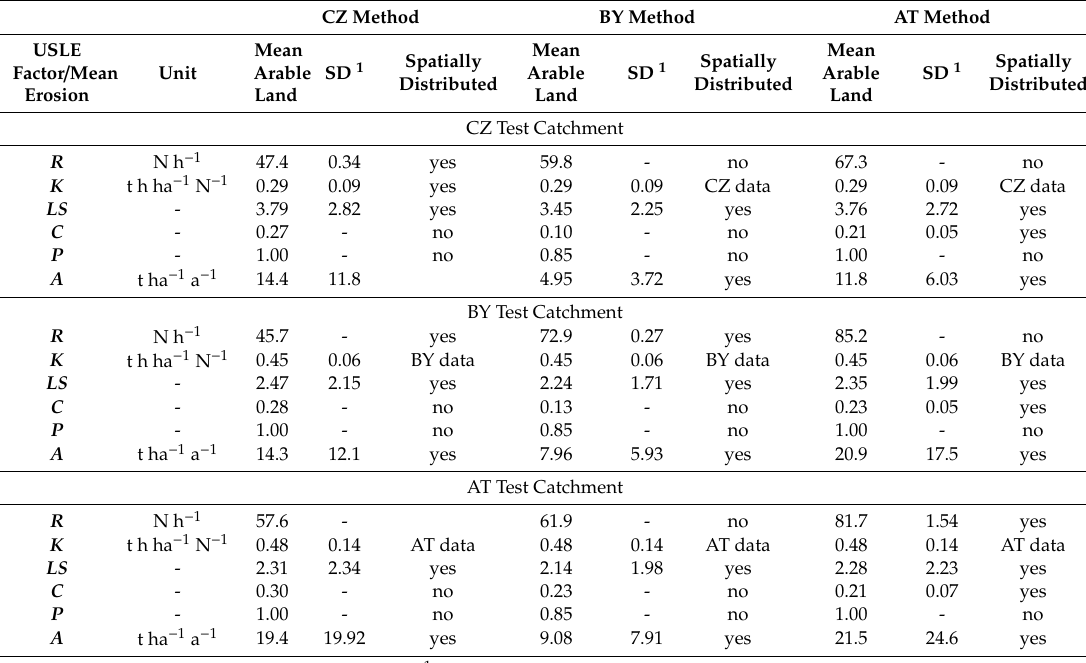
Table 3. USLE factors and mean annual erosion calculated from individual raster cells at the di ff erent test catchments in the Czech Republic (CZ), Germany Bavaria (BY), and Republic of Austria (AT) according to the di ff erent standard methods used in all three